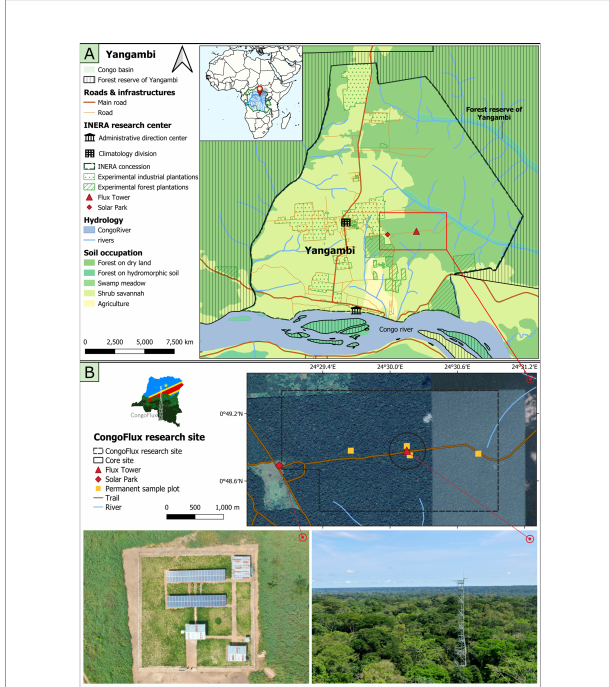
FIGURE 1 | Map of the research center of Yangambi in the Democratic Republic of the Congo (Panel (A) and detailed map of the CongoFlux research site (Panel (B) with illustrations of the solar park (Panel (B) bottom left) and the 55m-tall eddy covariance fl ux tower (Panel (B) bottom right). Source: Shape- fi les of Yangambi downloaded at https://maps.elie.ucl.ac.be/